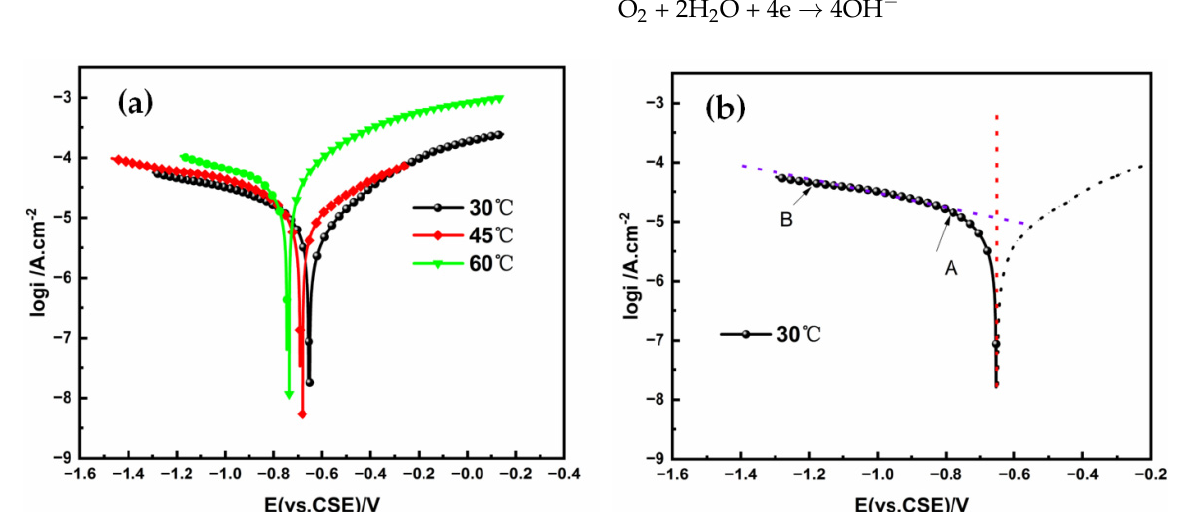
Figure 3. ( a ) Cathodic polarization curves of X80 at 30 °C; ( b ) Tafel polarization curves of X-80 in soil extracts at different temperatures.